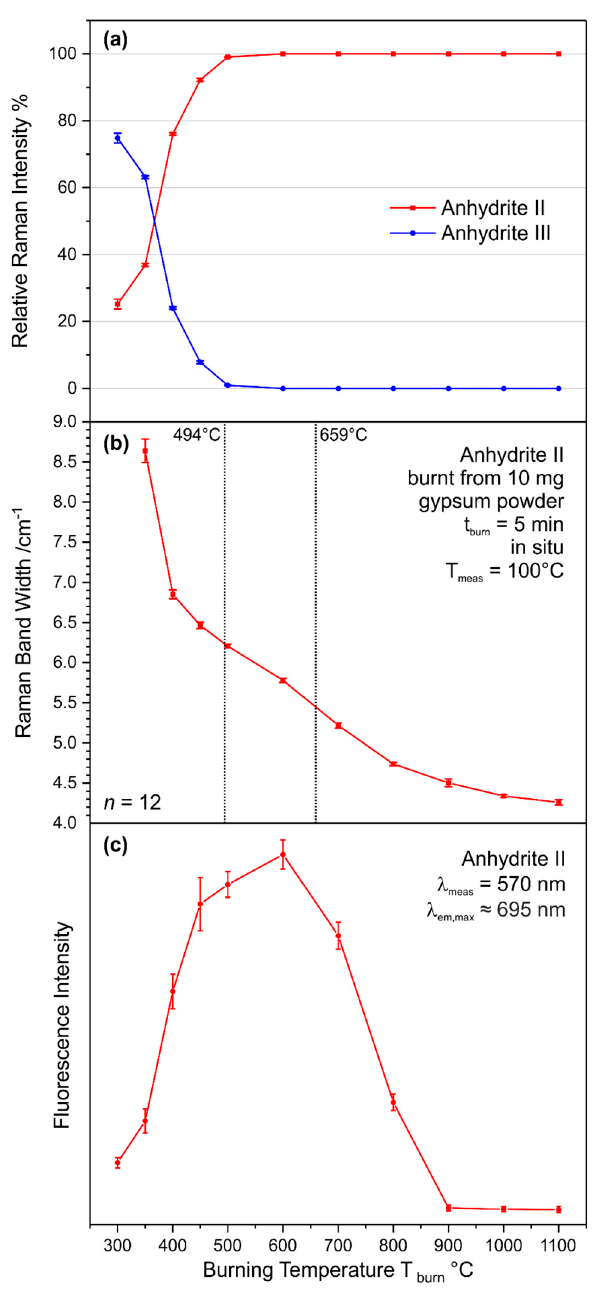
Figure 20. Results of in situ Raman measurements regarding the conversion reaction of anhydrite III to anhydrite II: ( a ) relative Raman intensities, ( b ) full widths at half maximum, and ( c ) intensity of autofluorescence emission by the material as functions of burning temperature T burn . All measurements were performed at T meas = 100 °C.